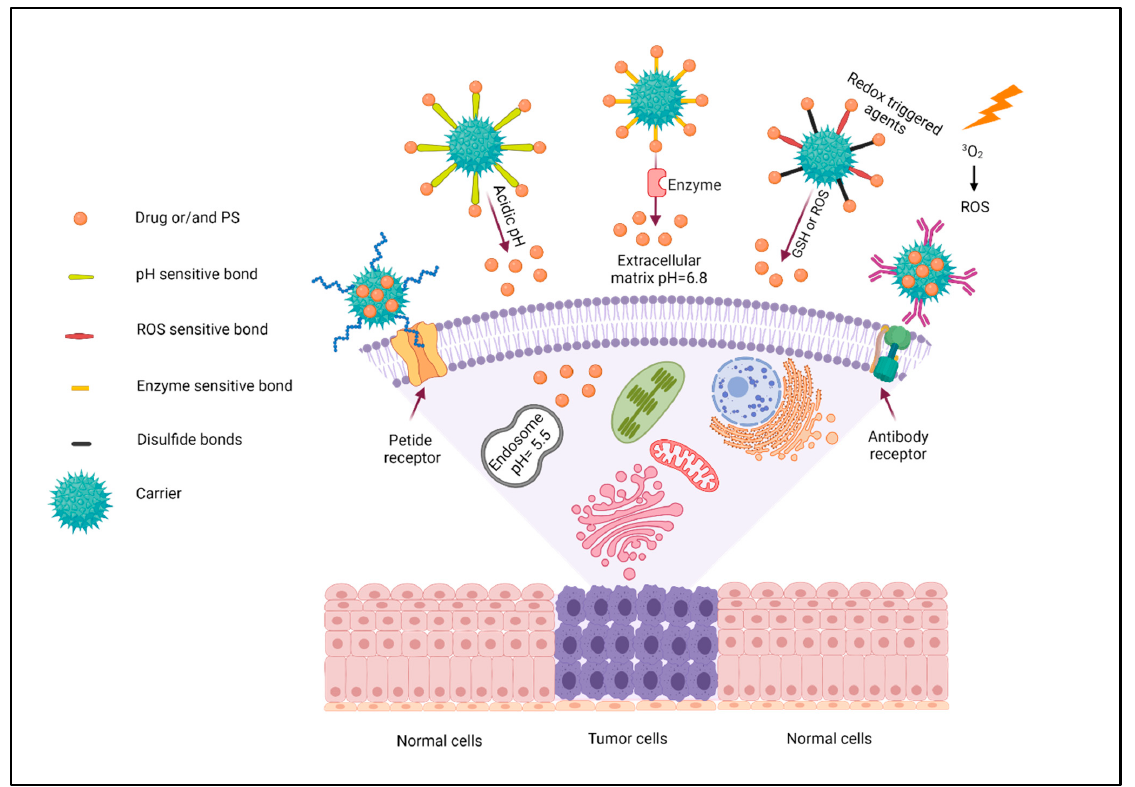
Figure 11. Schematic illustration of various targeting strategies in PDT (figure created with BioRender.com, access 17 January 2021).